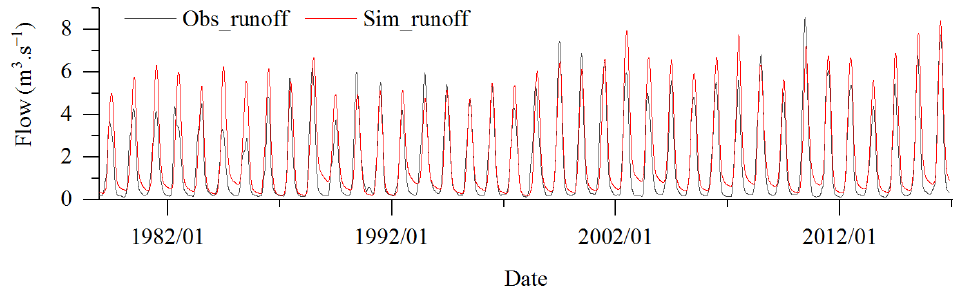
Figure 7. Comparison of the observed monthly flow and simulated monthly flow of YHG from 1979 to 2016.